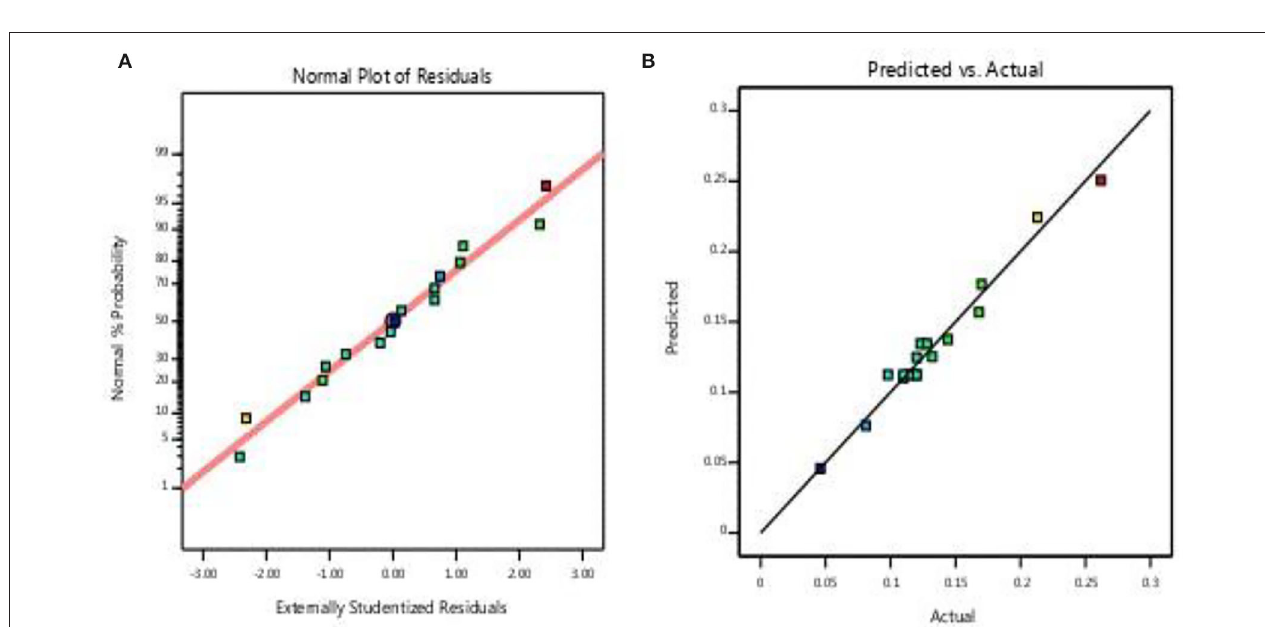
FIGURE 4 | (A) Normal probability and (B) predicted vs. actual